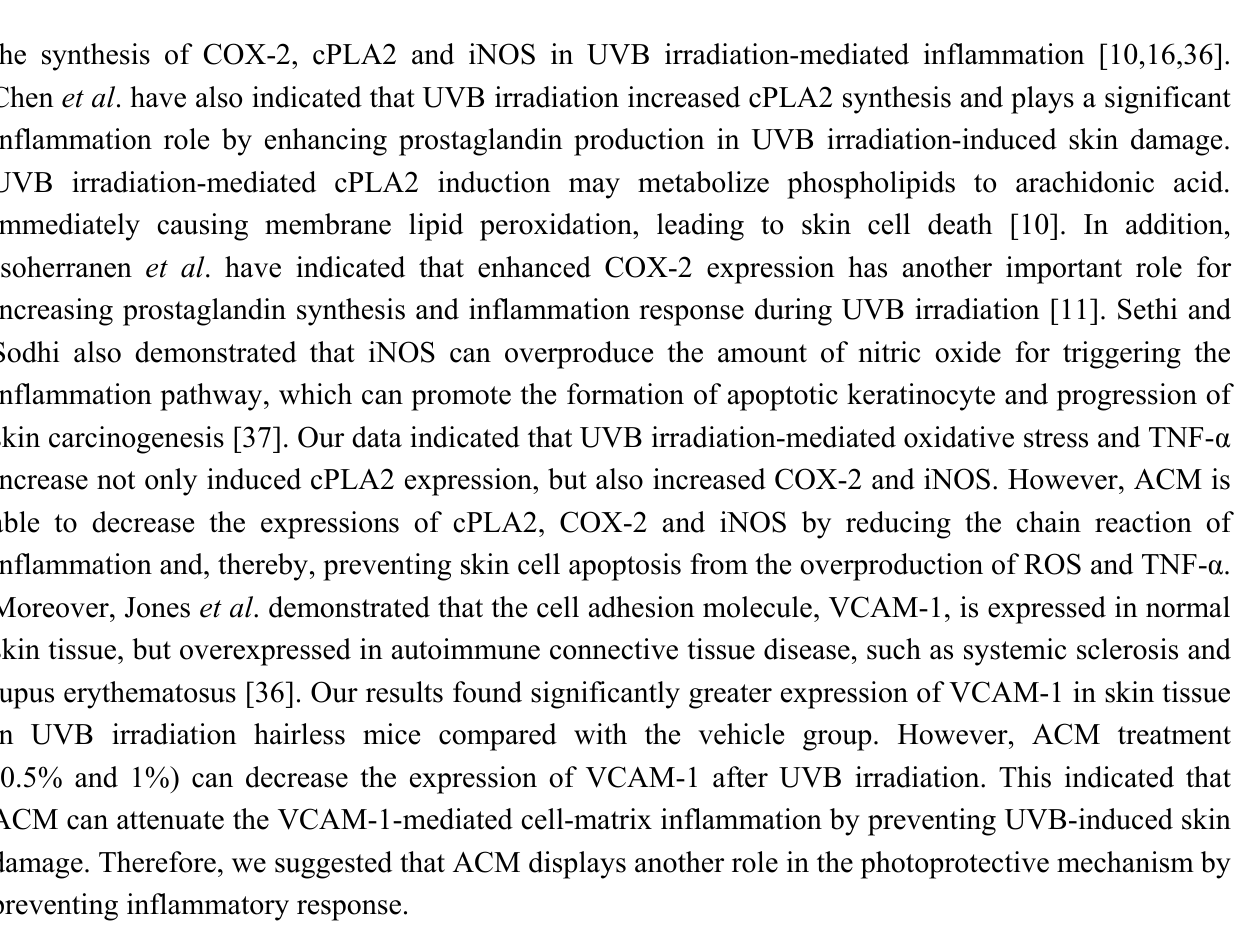
Figure 4. The pro-inflammatory cytokines of skin tissue on UVB-irradiated skin damage in hairless mice: ( A ) TNF- α ; and ( B ) IL-1 β . Values are expressed as mean ± SD, n =